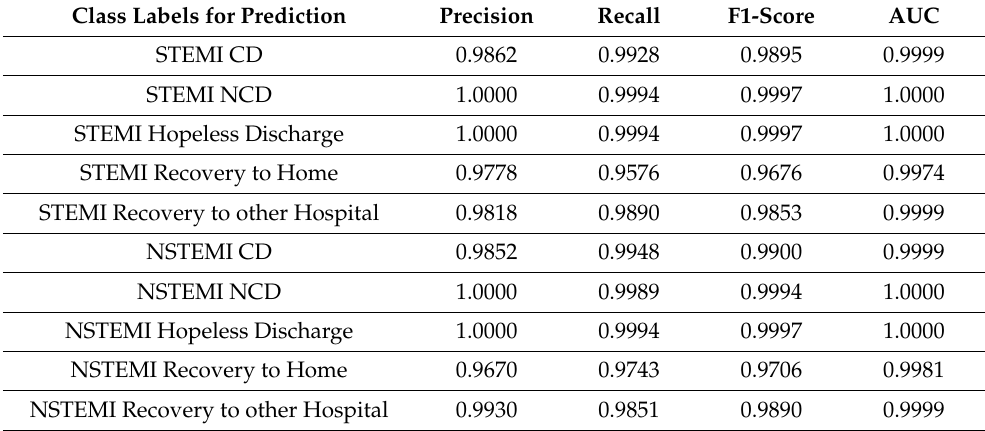
Table 3. Performance measures of all class labels for the Random Forest Classifier using in-hospital data.